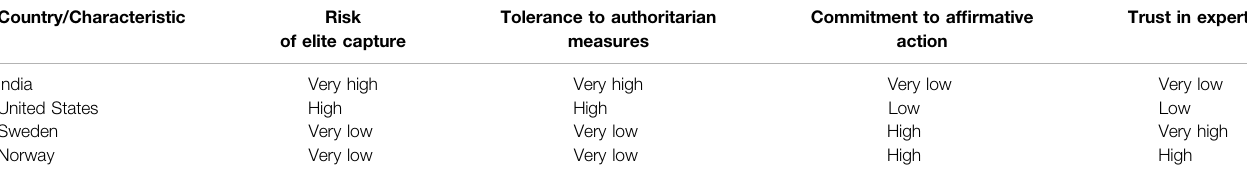
TABLE 4 | Hypothesizing propensities for four state characteristics by country.